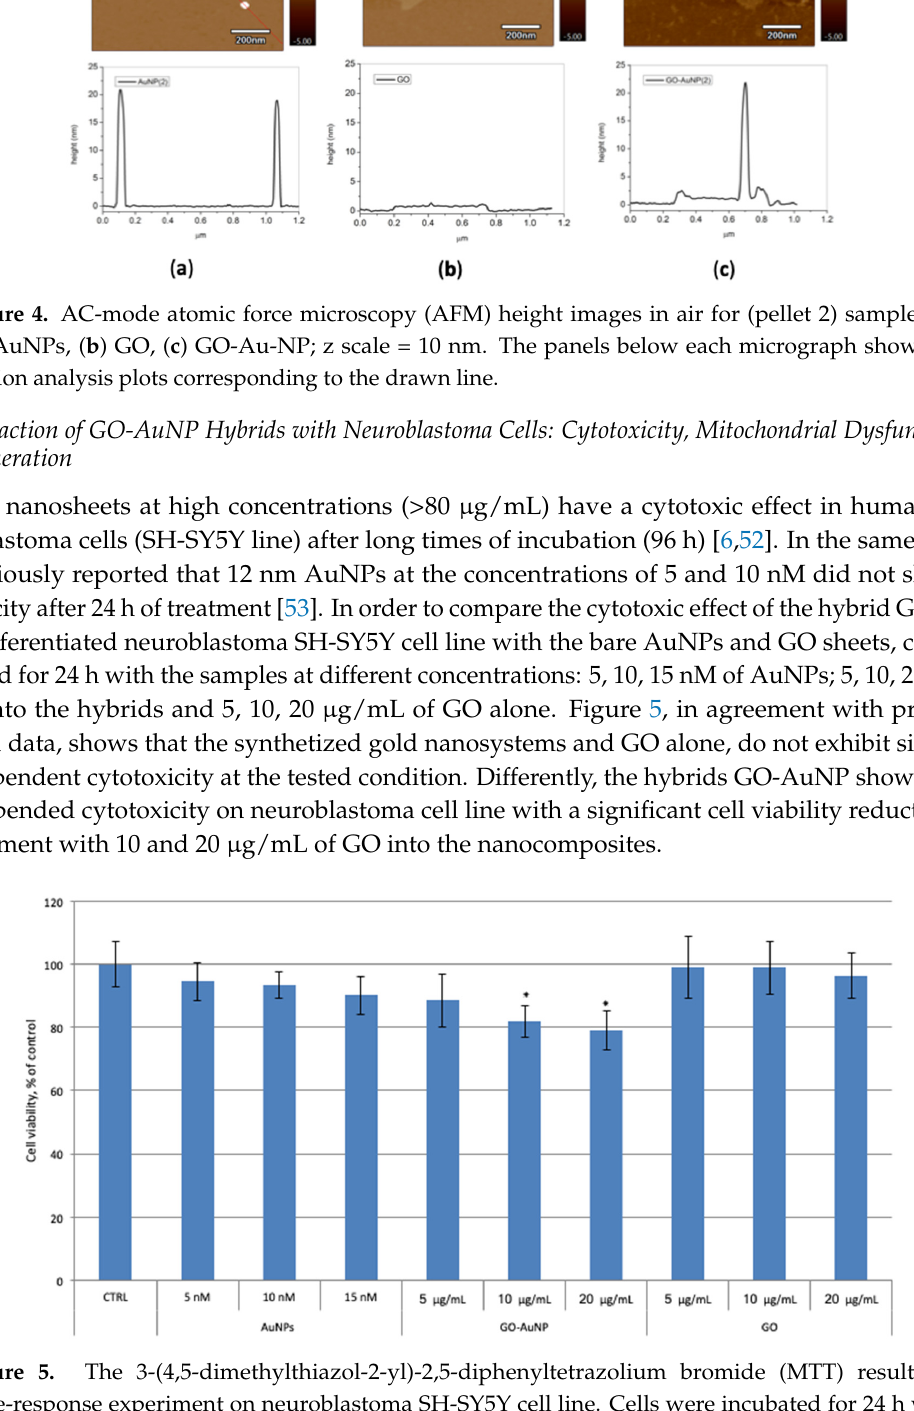
Figure 5. The 3-(4,5-dimethylthiazol-2-yl)-2,5-diphenyltetrazolium bromide (MTT) results of dose- response experiment on neuroblastoma SH-SY5Y cell line. Cells were incubated for 24 hrs